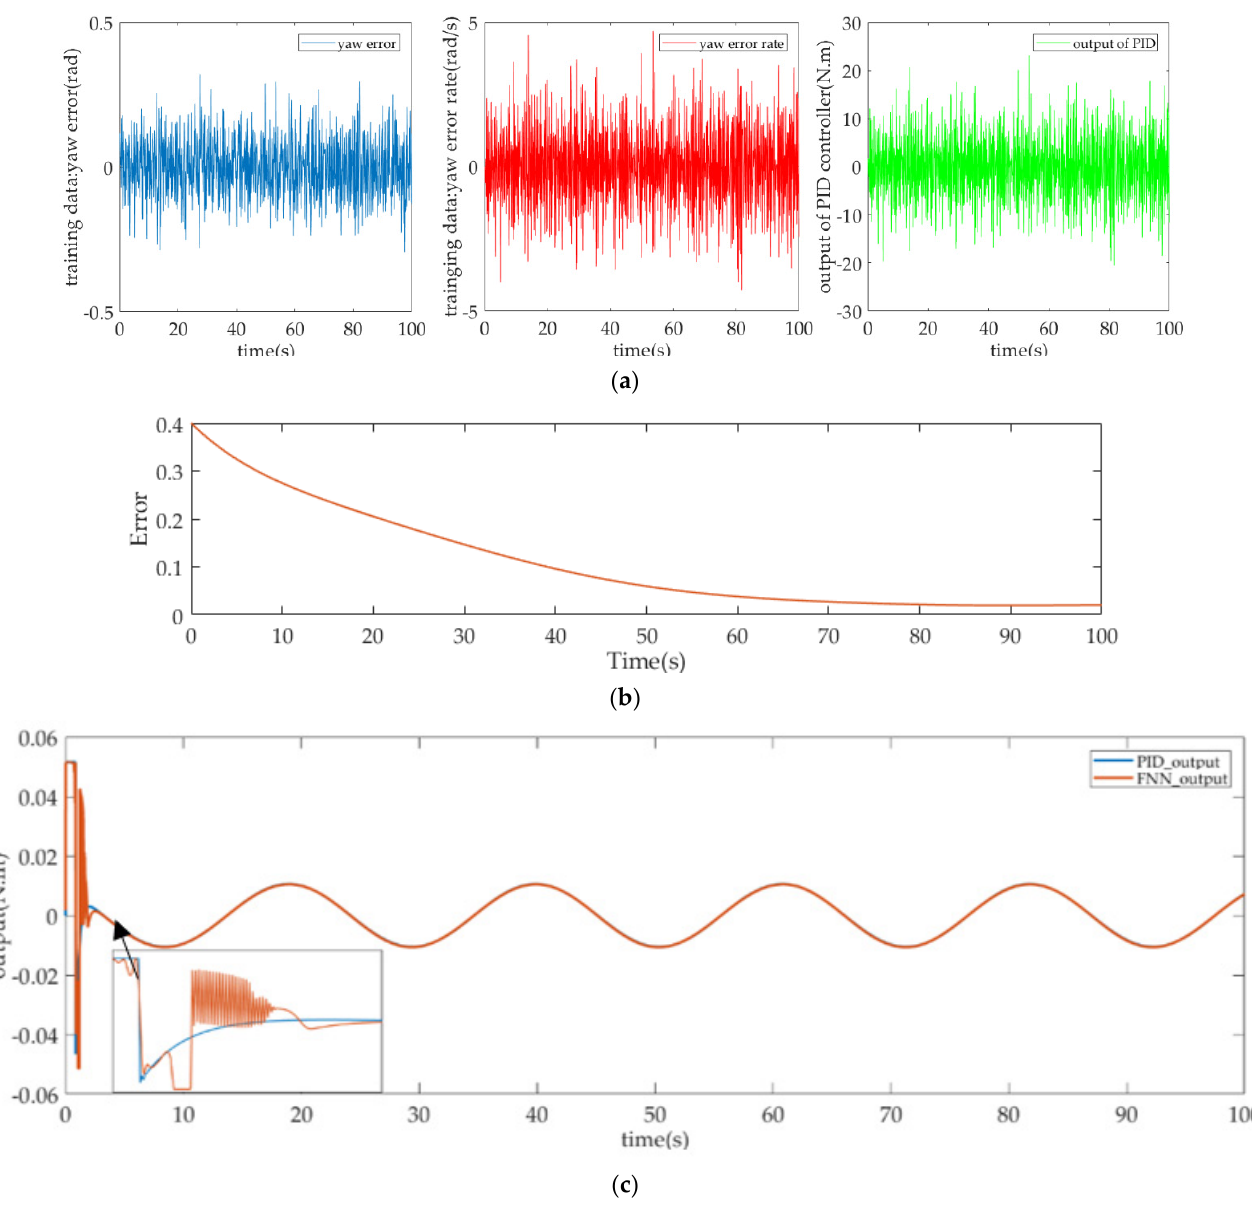
Figure 5. Training data sets, error chart, and validation results. ( a ) Training data sets; ( b ) error chart. ( c ) Comparison of the trained FNN controller and PID output verification.